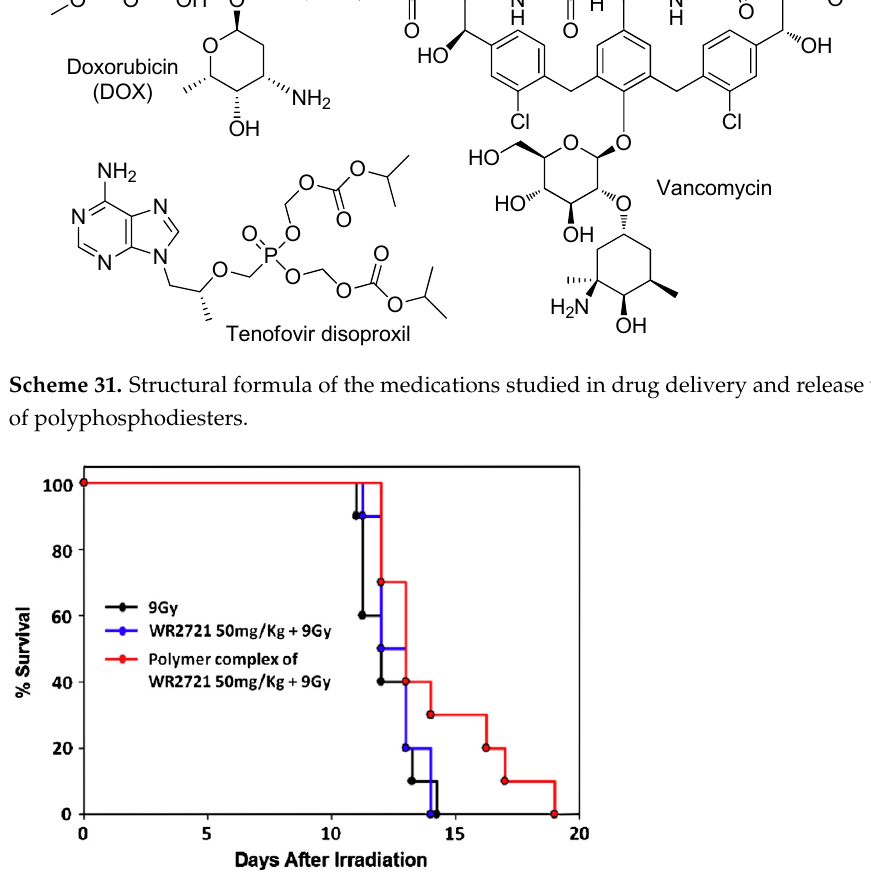
Figure 14. Overall survival of mice treated with 9 Gy whole body irradiation. The Kaplan–Meier plot shows percent survival plotted as a function of days after irradiation. Three groups of 10 mice each were exposed to 9 Gy WBI alone (black circles), WR2721 ip at a dose of 50 mg/kg 30 min prior to WBI (blue circles), or the polymer complex of WR2721 at an ip dose of 50 mg/kg 30 min prior to WBI (red circles). Reprinted with permission from [130]. Copyright (2014) Elsevier B. V.